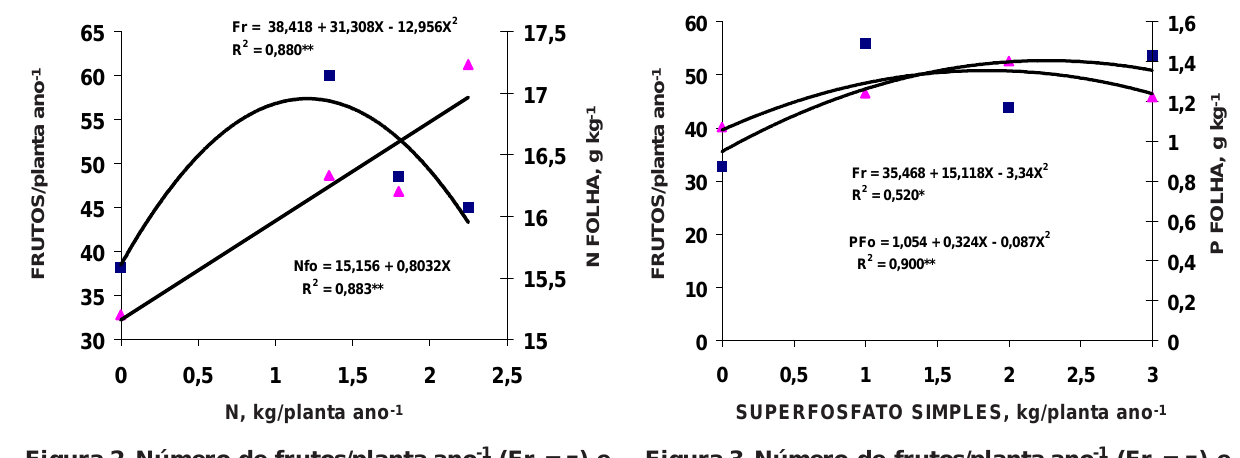
Figura 2. Número de frutos/planta ano -1 (Fr = n ) e teores de N na folha 14 do coqueiro (NFo = ), em função das doses de N-uréia no Podzólico Amarelo. ** significativo a 1%.